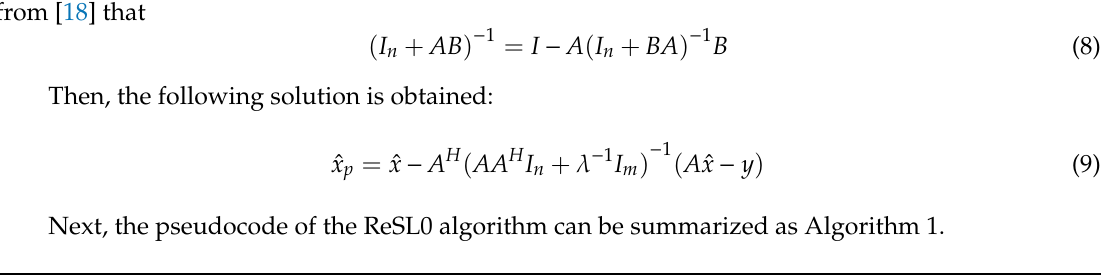
Algorithm 1. The pseudo-code of the ReSL0 algorithm.